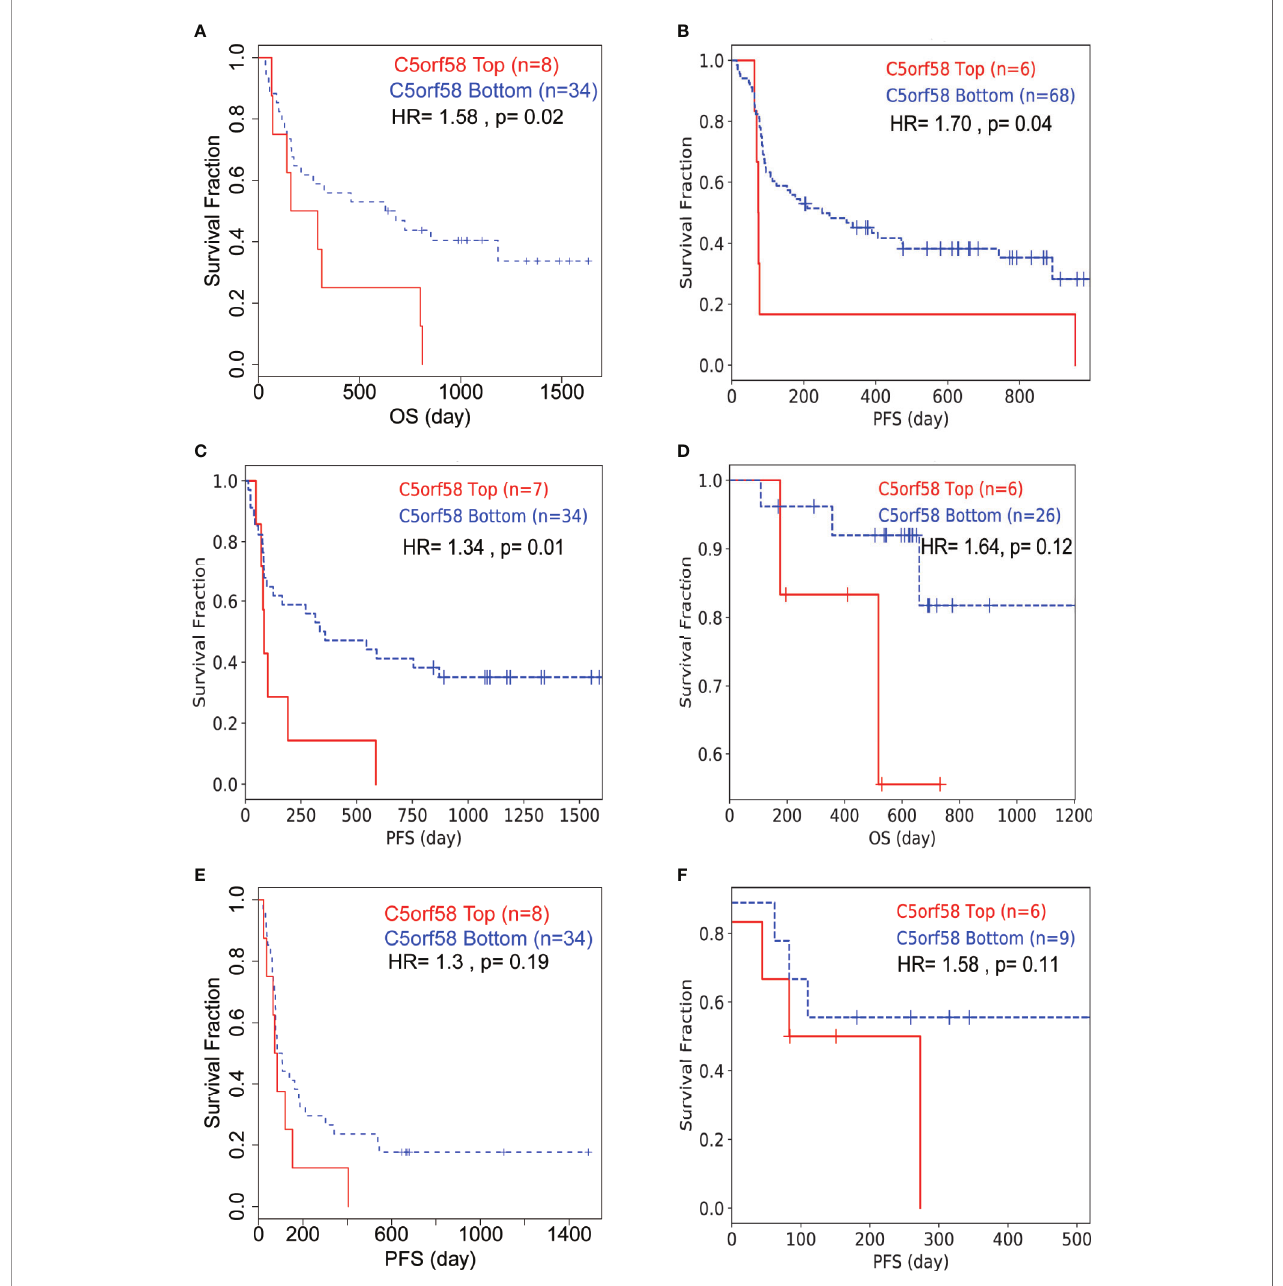
FIGURE 8 | ICLs confer immune checkpoint inhibitor resistance in human cancer. (A, D, E) Melanoma patients with high expression of C5orf58 indicated worse response to anti-PD-1/anti-CTLA-4 combined therapy and worse overall survival or progression-free survival in three datasets. (B) Melanoma patients with high expression of C5orf58 who received single anti-PD-1 monotherapy showed worse response and worse progression-free survival. (C) Melanoma patients with high expression of C5orf58 who received single anti-CTLA-4 monotherapy showed worse response and worse progression-free survival. (F) Glioblastoma patients with high expression of C5orf58 who received anti-PD-1 monotherapy showed worse response and worse progression- free